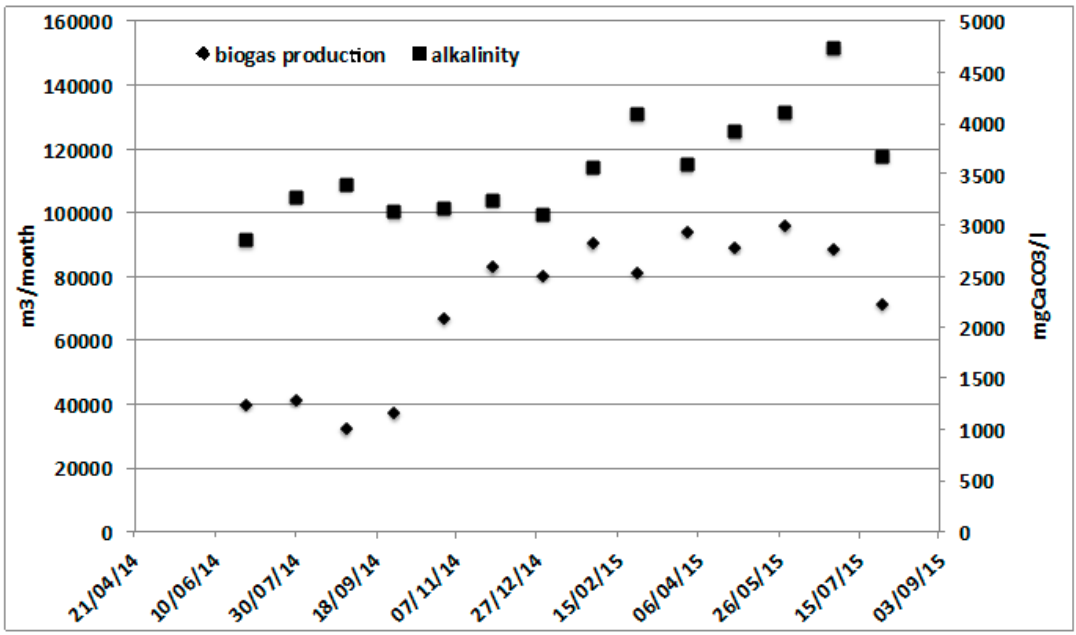
Figure 4. Temperature, total alkalinity, and organic loading rate behavior during eight years of anaerobic codigestion process monitoring of the Treviso anaerobic digestion (AD) process.